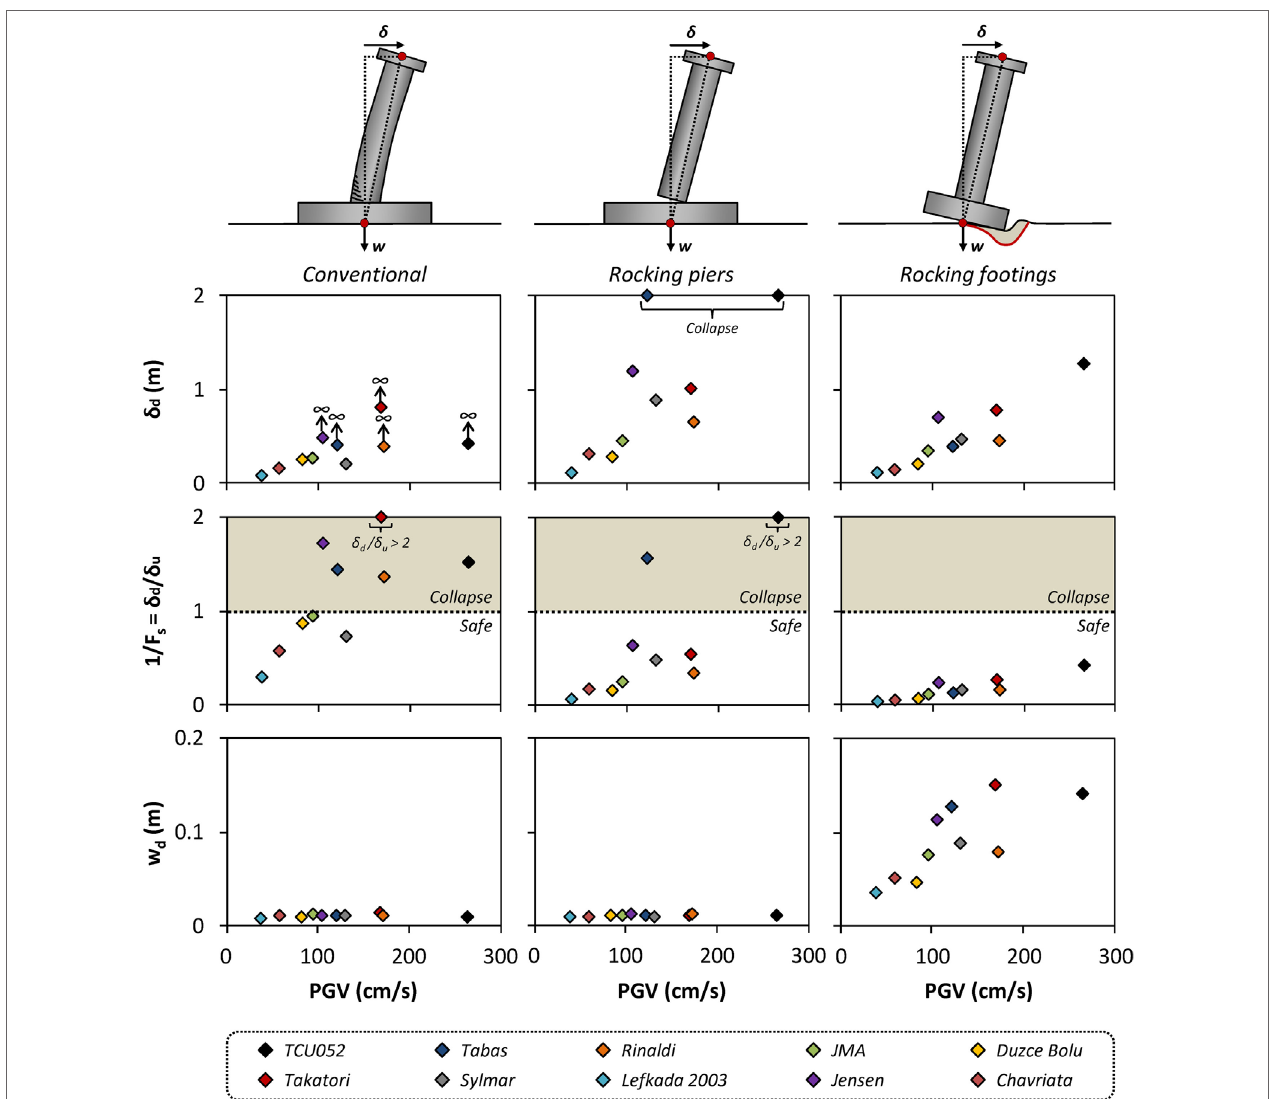
FigUre 14 | Summary of the response of the three examined systems in terms of maximum drift δ d , displacement demand over displacement capacity δ d / δ u , and maximum settlement w d with respect to the peak ground velocity PGV for the selected ensemble of 20 records (10 ground motions of two perpendicular components